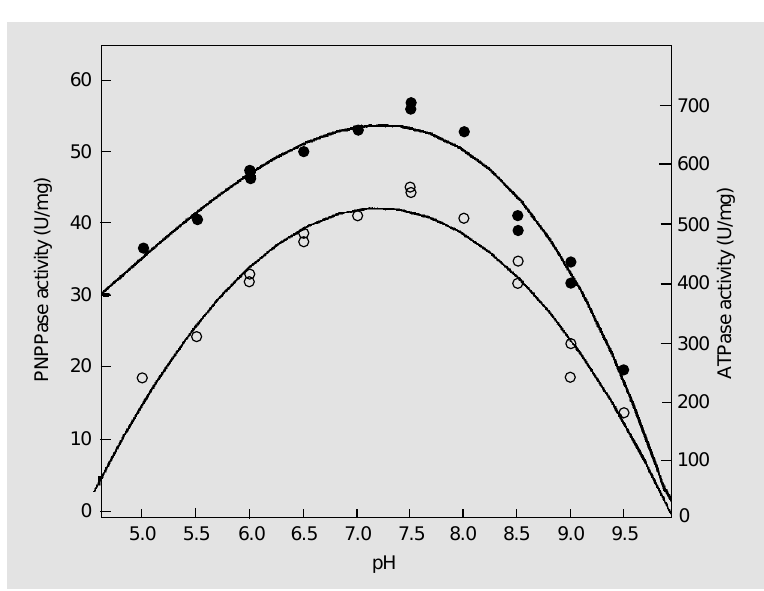
Figure 6. pH sensitivity of the hydrolysis of p-nitrophenyl phosphate (PNPP) and adenosine 5’-triphosphate (ATP) by Na,K-ATPase solubilized with C 12 E 8 (1:1, w/w) and purified on a Sepharose 6B column. PNPPase (filled circles) and ATPase activities (open circles) are shown. Assays were buffered with 50 mM buffer containing 5 mM MgCl 2 , 10 mM KCl and 50 mM NaCl and the substrate, i.e., 10 mM PNPP or 3 mM ATP (for details, see Material and Methods). The reaction was started by the addition of 3.5 µg protein.